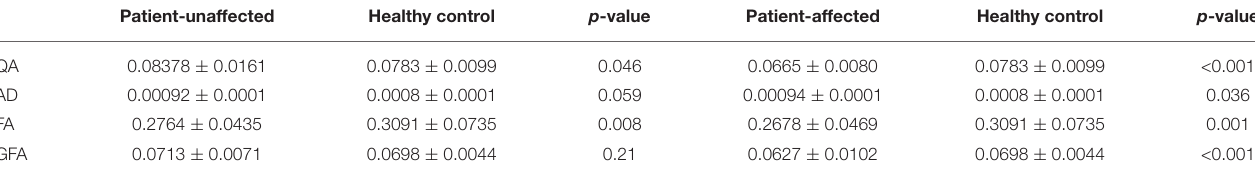
TABLE 3 | Compared with patients and healthy